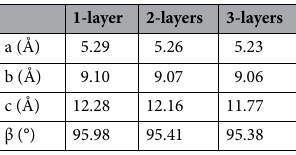
Table 2. Calculated structural data of mica nanosheets.